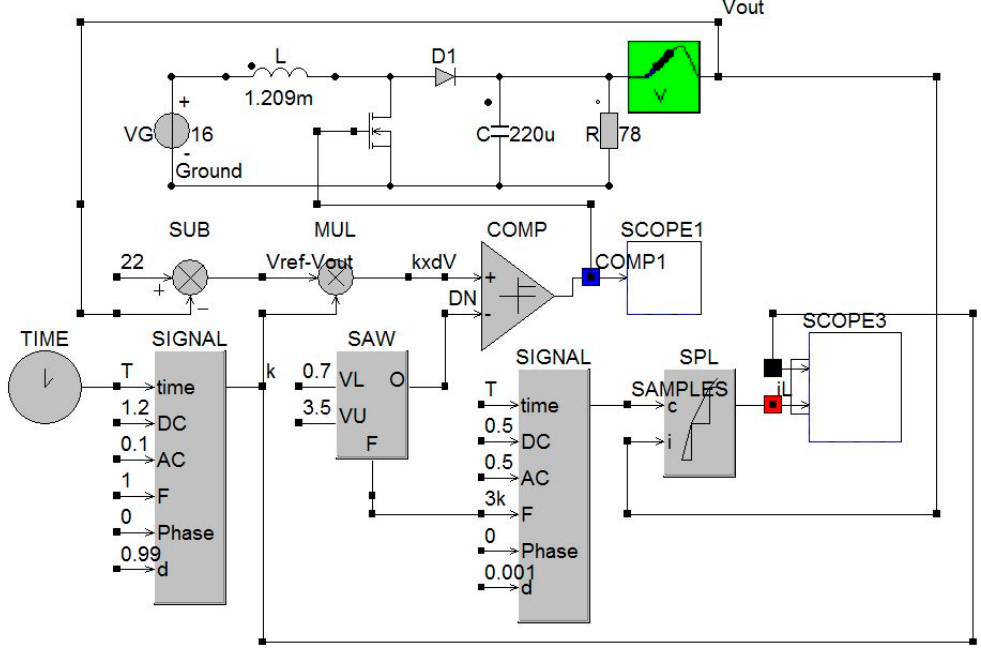
Figure 4. Caspoc™ schematic for the proportional voltage-mode controlled boost converter.